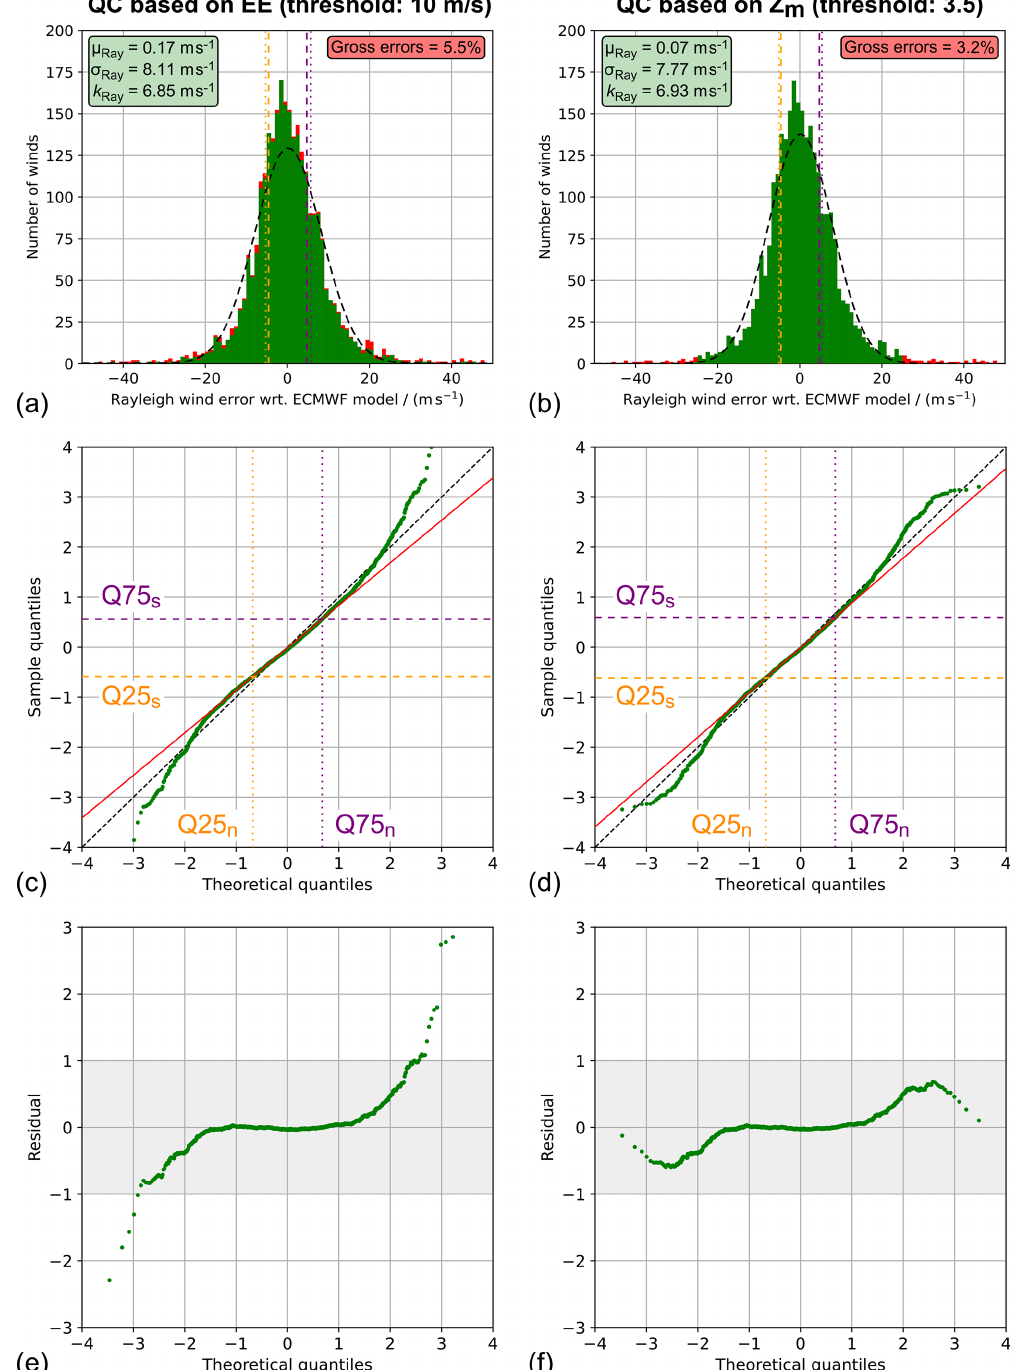
Figure 5. Normality check of the Rayleigh-clear wind error distribution from the ECMWF model comparison based on the AVATAR-T dataset for two different QC approaches. (a, b) Histograms of the Rayleigh wind error with respect to the ECMWF model background (a) after QC based on an EE threshold of 10ms − 1 and after QC based on the modified Z score ( | Z m | > 3 . 5). The vertical dashed lines indicate the first and third quartiles of the given (sample) distribution (Q25 s ; Q75 s ) and the theoretical normal distribution used for comparison (Q25 n ; Q75 n ). The corresponding parameters are also visualized as horizontal and vertical dashed lines (quartile lines) in the normal quantile plots for the two QC approaches plotted in panels (c) and (d) , respectively. The quartile reference line (red), which is defined by the intersection points of the quartile lines, is used to calculate the residual quantiles which are depicted in panels (e) and (f)